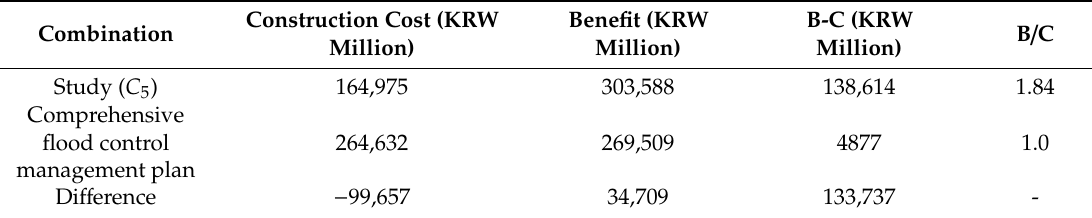
Table 8. Comparison results of two